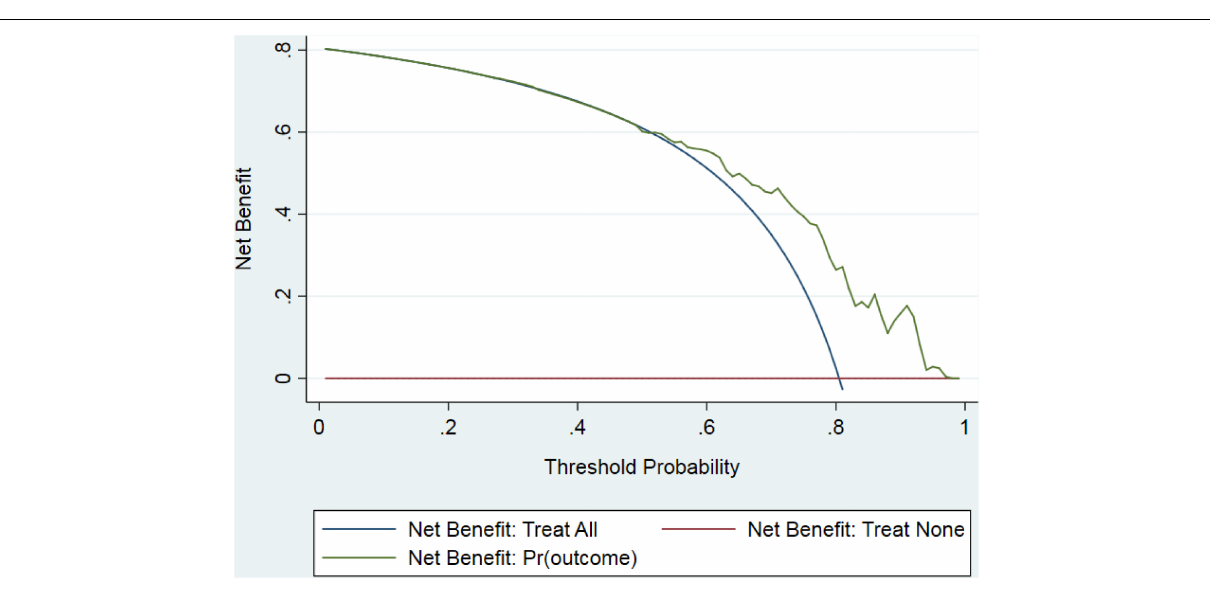
FIGURE 5 | Decision curve for peritonitis-related catheter removal. Outcomes generated by the prediction model (green line) were distinct from those generated by “all” or “none” treatment strategies (blue or red lines), indicating that the use of the model might lead to improved clinical